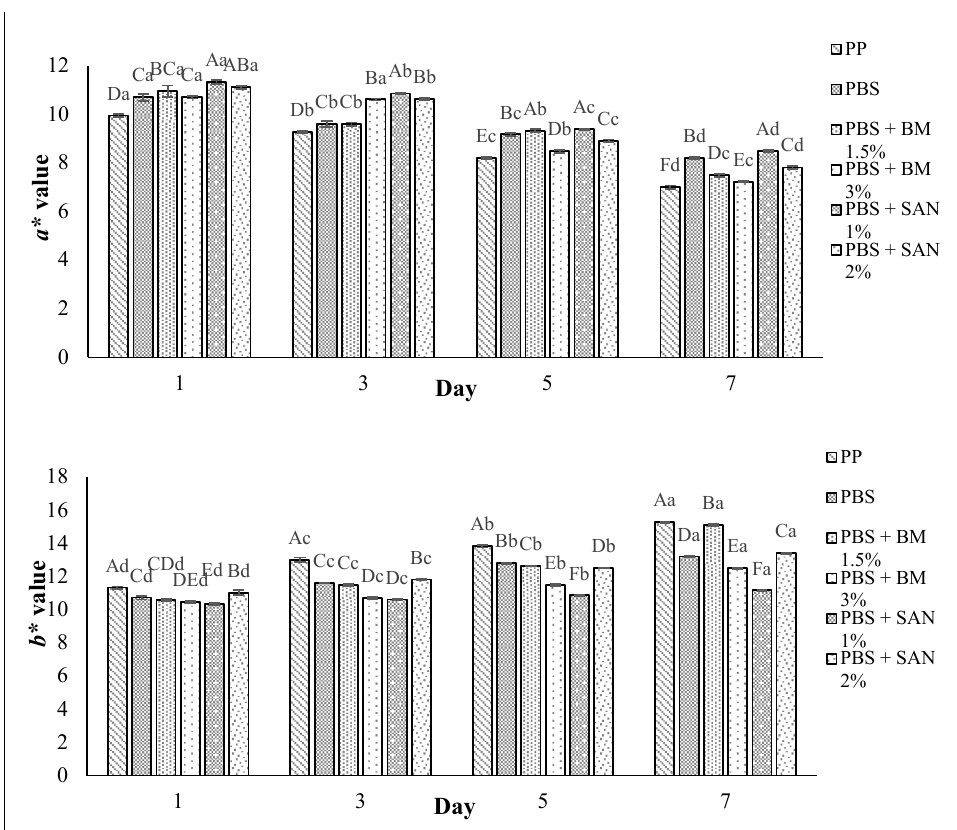
Figure 9. The L*, a*, and b* values of chicken breast fillets stored in PP container and PBS film laminated tray during storage at 4 ◦ C for seven days. Note: Color parameters: L* (from 0 black to 100 white), a* (from -a* green to +a* red), and b* (from -b* blue to +b* yellow). PP: polypropylene microwavable container (control); PBS: PBS film (untreated); PBS + BM 1.5%: PBS film + 1.5% Biomaster silver; PBS + BM 3%: PBS film + 3% Biomaster silver; PBS + SAN 1%: PBS film + 1% SANAFOR; PBS + SAN 2%: PBS film + 2% SANAFOR. Error bars indicate standard deviation (n = 3). The different A–F capital letters are significantly different ( p < 0.05) among treatment for each day. The different a–d lowercase letters are significantly different ( p < 0.05) among storage day for each sample.